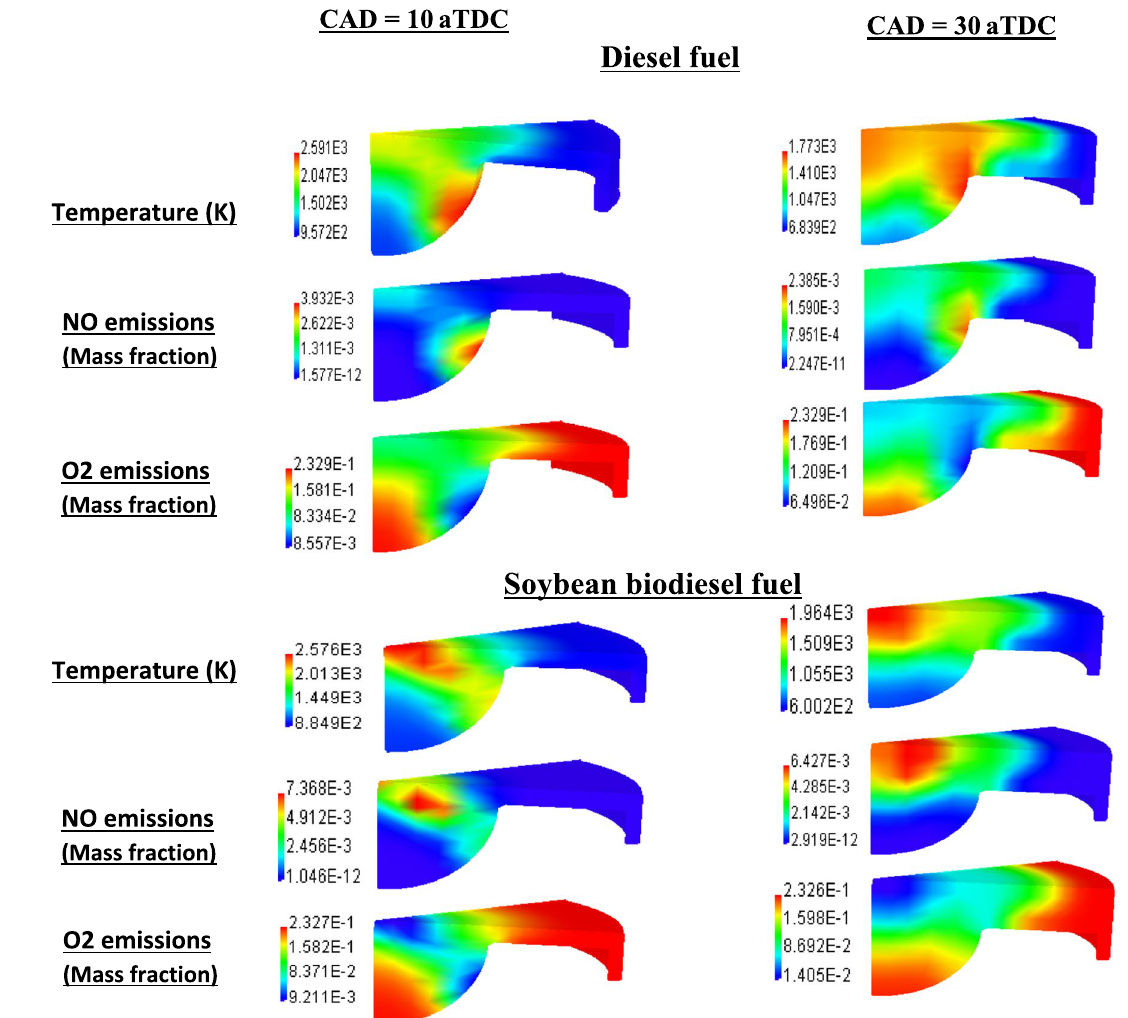
Fig. 15 Spatial distributed temperatures, NO and O 2 emissions at 10 CAD and 30 CAD aTDC for diesel and soybean biodiesel